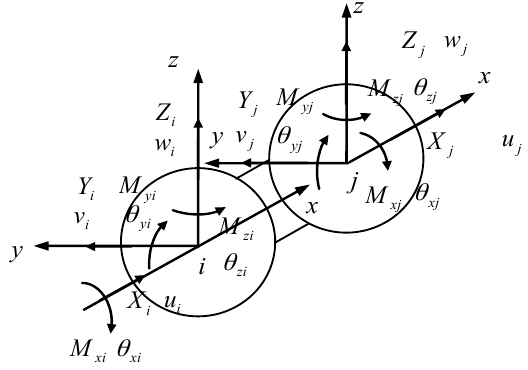
Figure 5. Nodal displacement and nodal force of CSE.